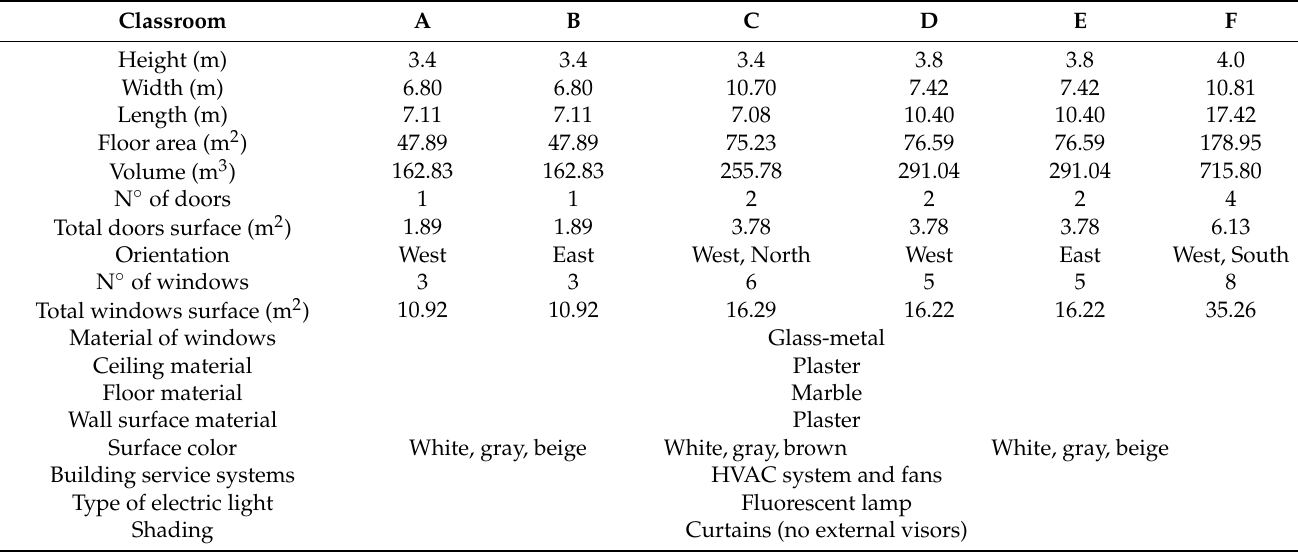
Table 1. Characteristics of the investigated